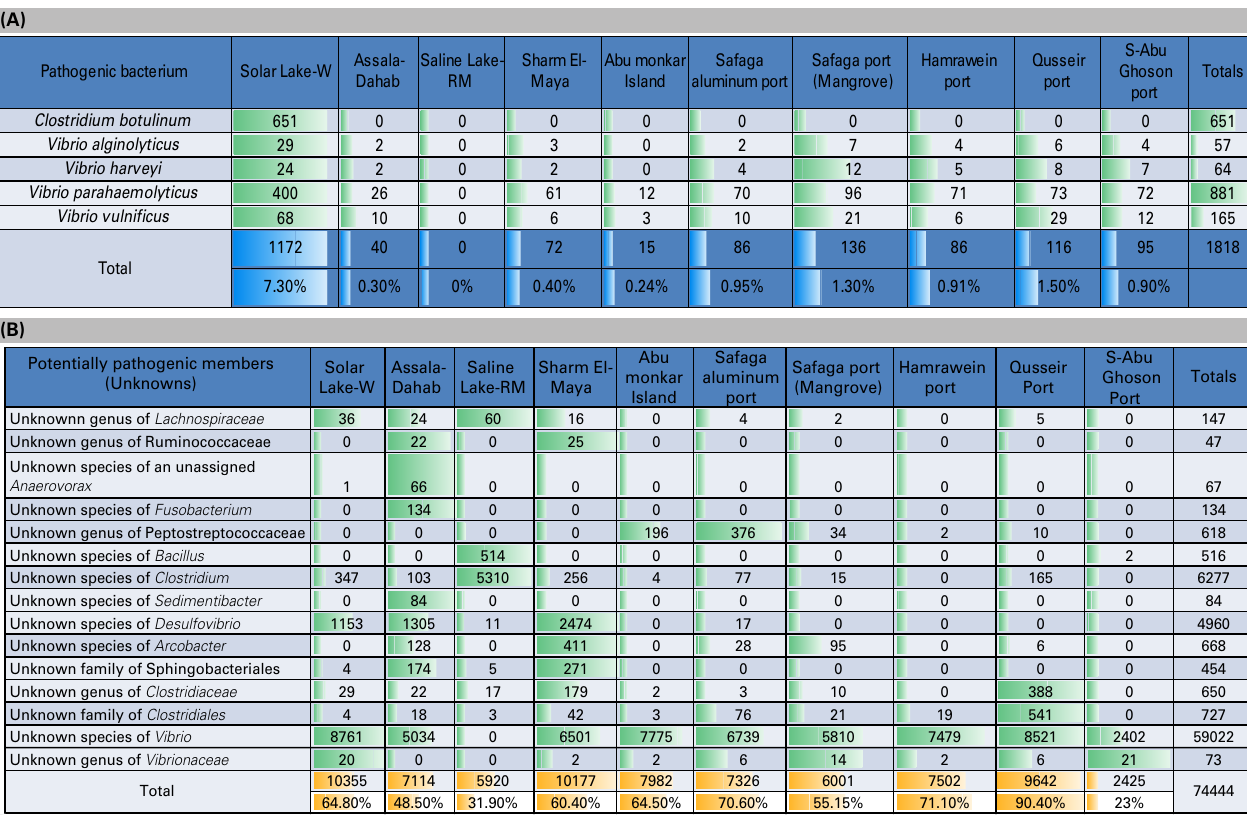
Table 4 | (A) Preliminary assignment of total number of reads to known human pathogens, (B) Total number of reads assigned to potential pathogens (previously reported genera/species included human pathogens and